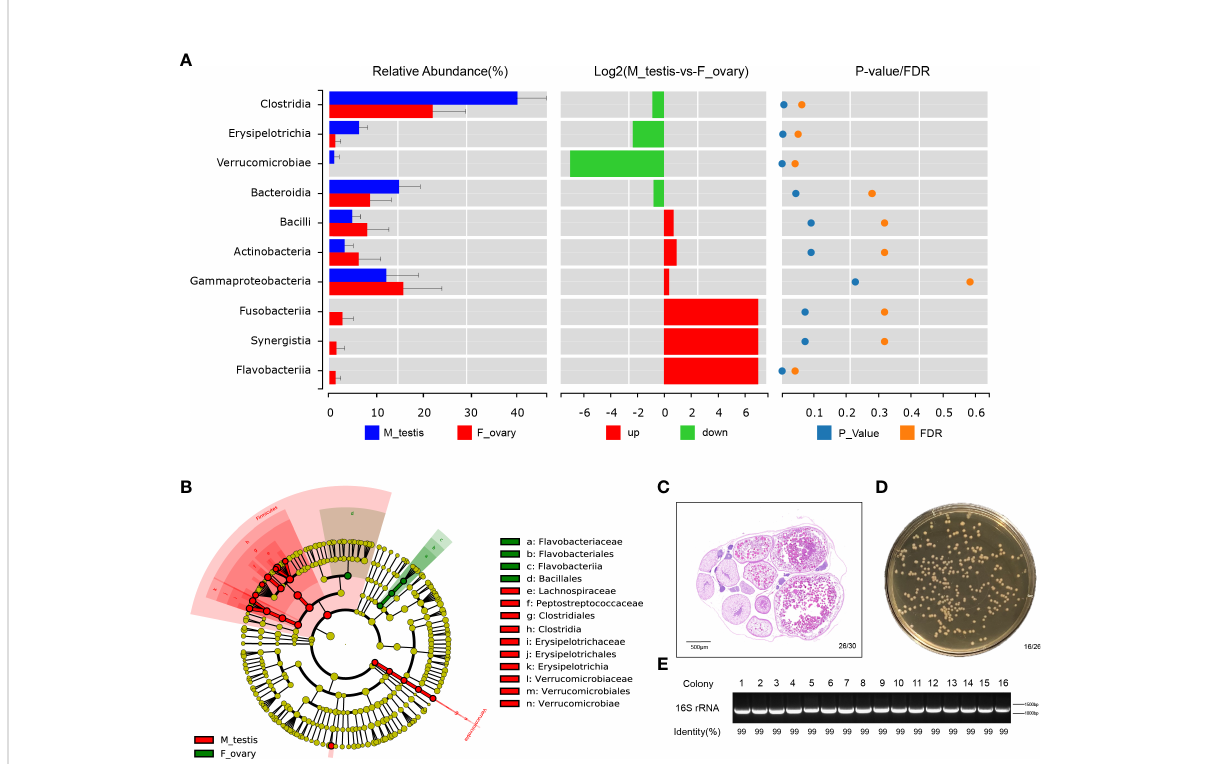
FIGURE 5 Bacterial community are signi fi cantly different between ovary and testis in M. albus . (A) Differences in microbial communities at the class level. (B) Cladogram representation of LEfSe analysis shows that bacterial taxa are signi fi cantly associated with the ovary (green) or testis (red). (C) Representative graphs of ovary histology in M. albus . (D) Culture plates from gonads of M. albus . Black triangles indicate single colonies of Bacillus . (E) Agarose gel electrophoresis of colony PCR samples. PCR products were veri fi ed by agarose gel electrophoresis and